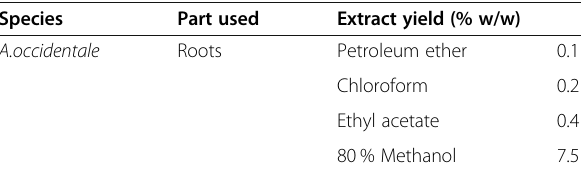
Table 1 The percentage yield of extracts of Anacardium occidentale roots Species Part used Extract yield (%